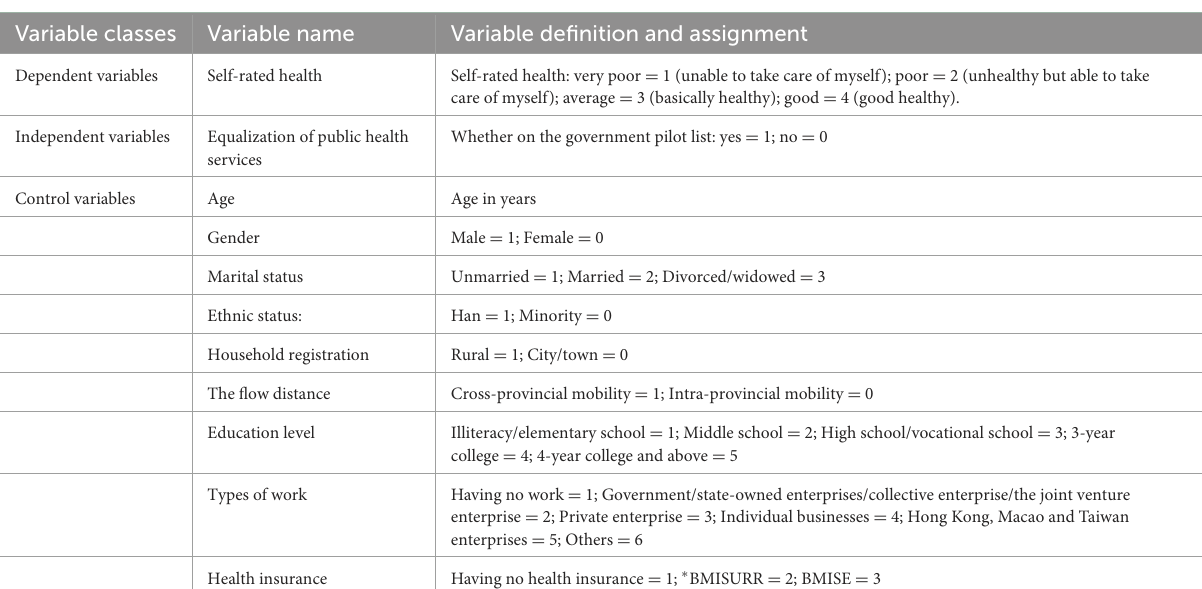
TABLE 1 Variable selection, definition, and